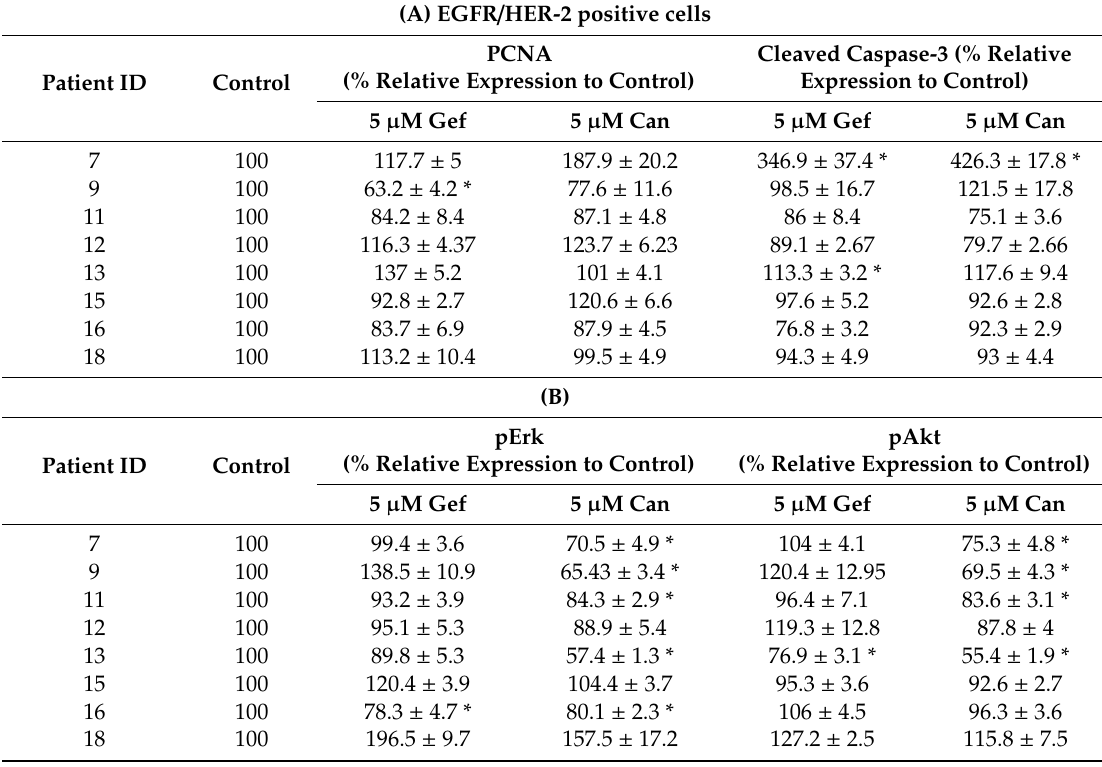
Table 6. The expressions of PCNA, cleaved caspase-3, pERK (Tyr 204) and pAKT (Ser 473) in EGFR / HER-2 positive cells are a ff ected by gefitinib (Gef) and canertinib (Can). The changes of PCNA and cleaved caspase-3 in Gef and Can treated cells are limited ( A ). The decreases in pERK (Tyr 204) and pAKT (Ser 473) are more evident on Can than Gef treated cell samples ( B ). The fluorescent intensity of the control is normalised to 100% and the fluorescent intensity of treatment is calculated relative to the control sample. Representative analysis is presented from a set of two independent experiments and each experiment had at least three duplicates (mean ± SE; n = 2). Statistical significance was determined by a t -test ( * , p <